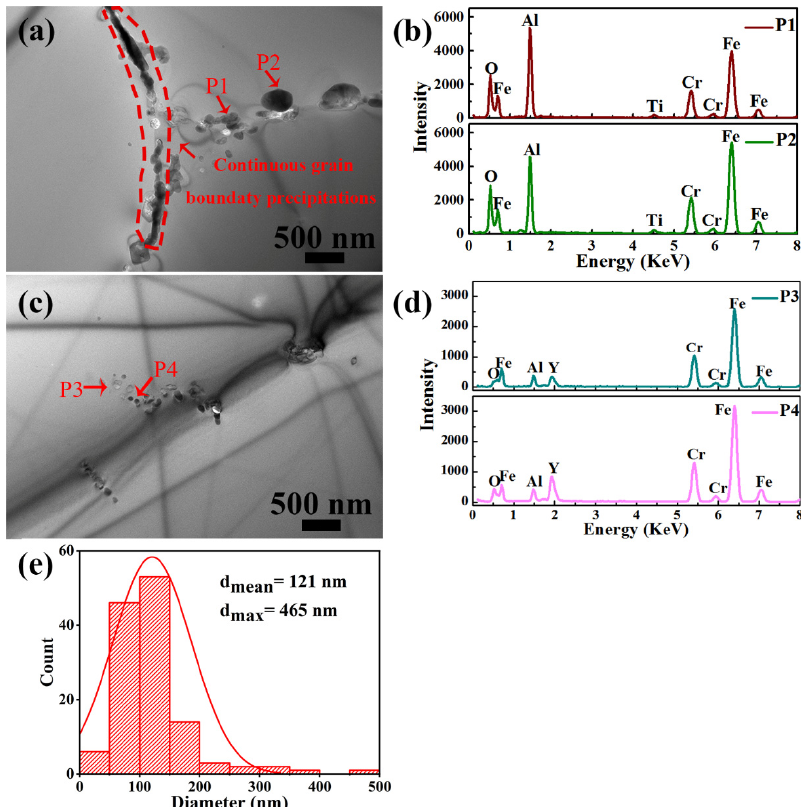
Figure 4. TEM images of ( a ) continuous precipitates at grain boundaries and continuous precipitates within grains; ( b , d ) EDS spectra of the arrowed precipitates in ( a , c ) for the as-HIPed sample, ( e ) the diameter statistical histogram of oxides in the as-HIPed sample.